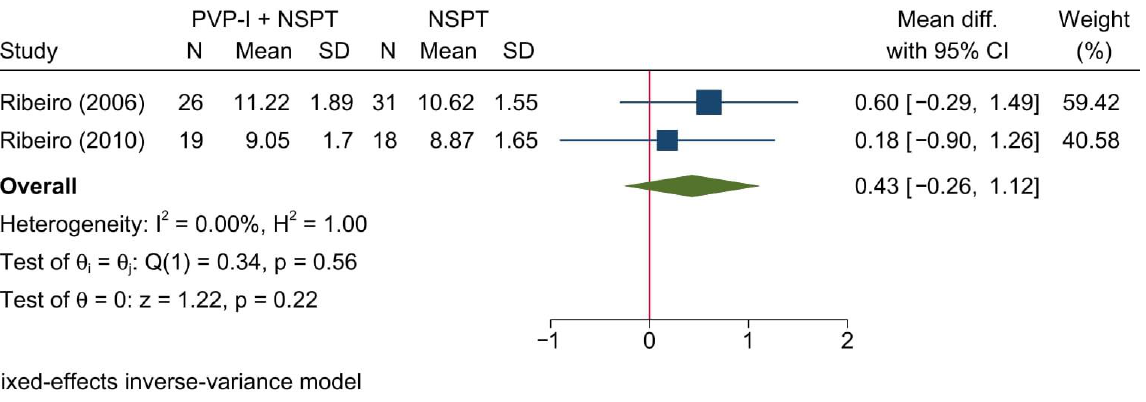
Figure 5. Forest plot showing the comparison between PVP-I + NSPT and NSPT alone regarding relative horizontal attachment level [31,46].